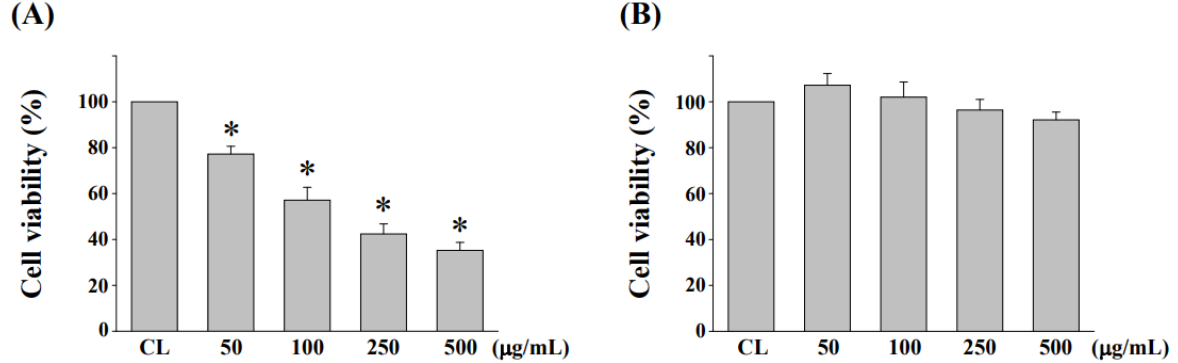
Figure 2. Evaluation of cytotoxicity of ginger extract in NaDES after fermentation. NCM460 cells were cultured in the presence of ( A ) non-fermented NaDES-ginger extract and ( B ) fermented NaDES-ginger extract for 24 h, and cell cytotoxicity was determined by MTT assay. Data represent the mean ± standard error of the mean from three independent experiments; * p < 0.05 vs. CL NCM460 cells.